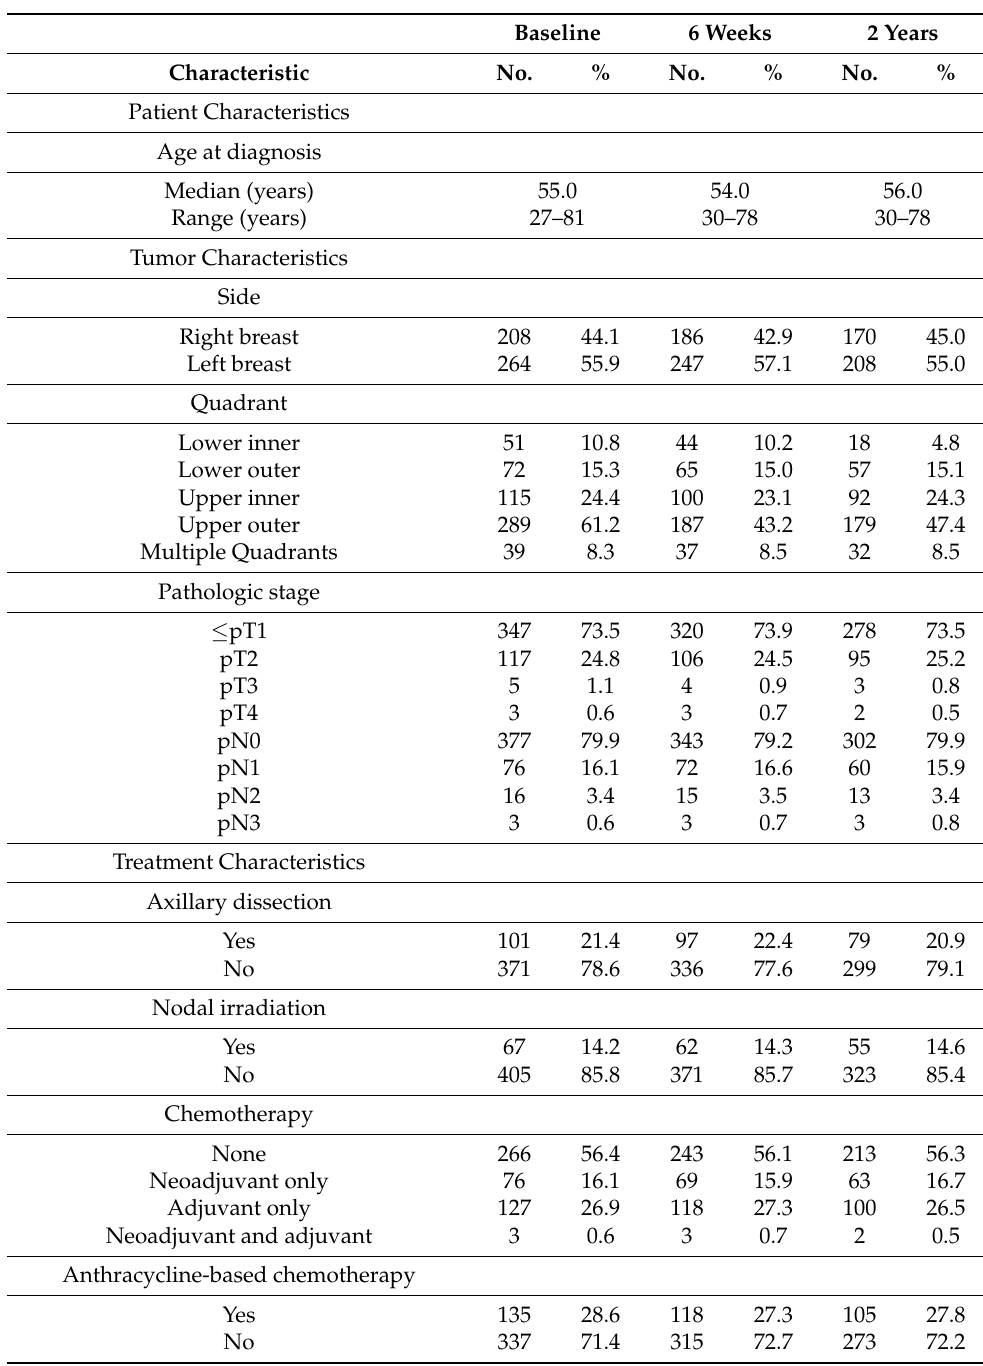
Table 1. Patient, tumor, and treatment